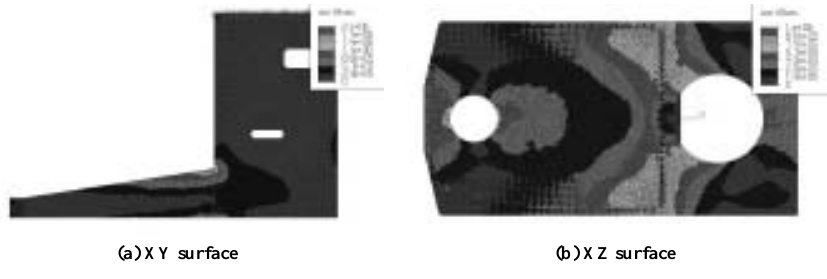
Fig. 26. Strress distribution of bond head stand with